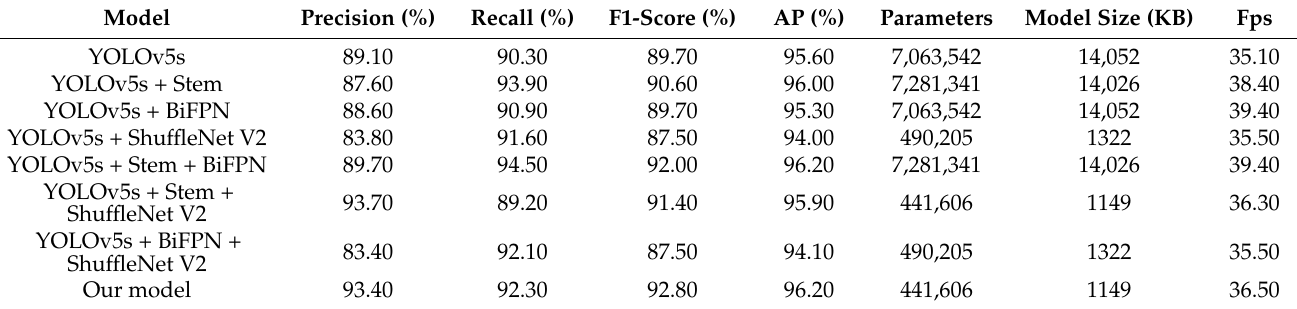
Table 3. The model performance with a different